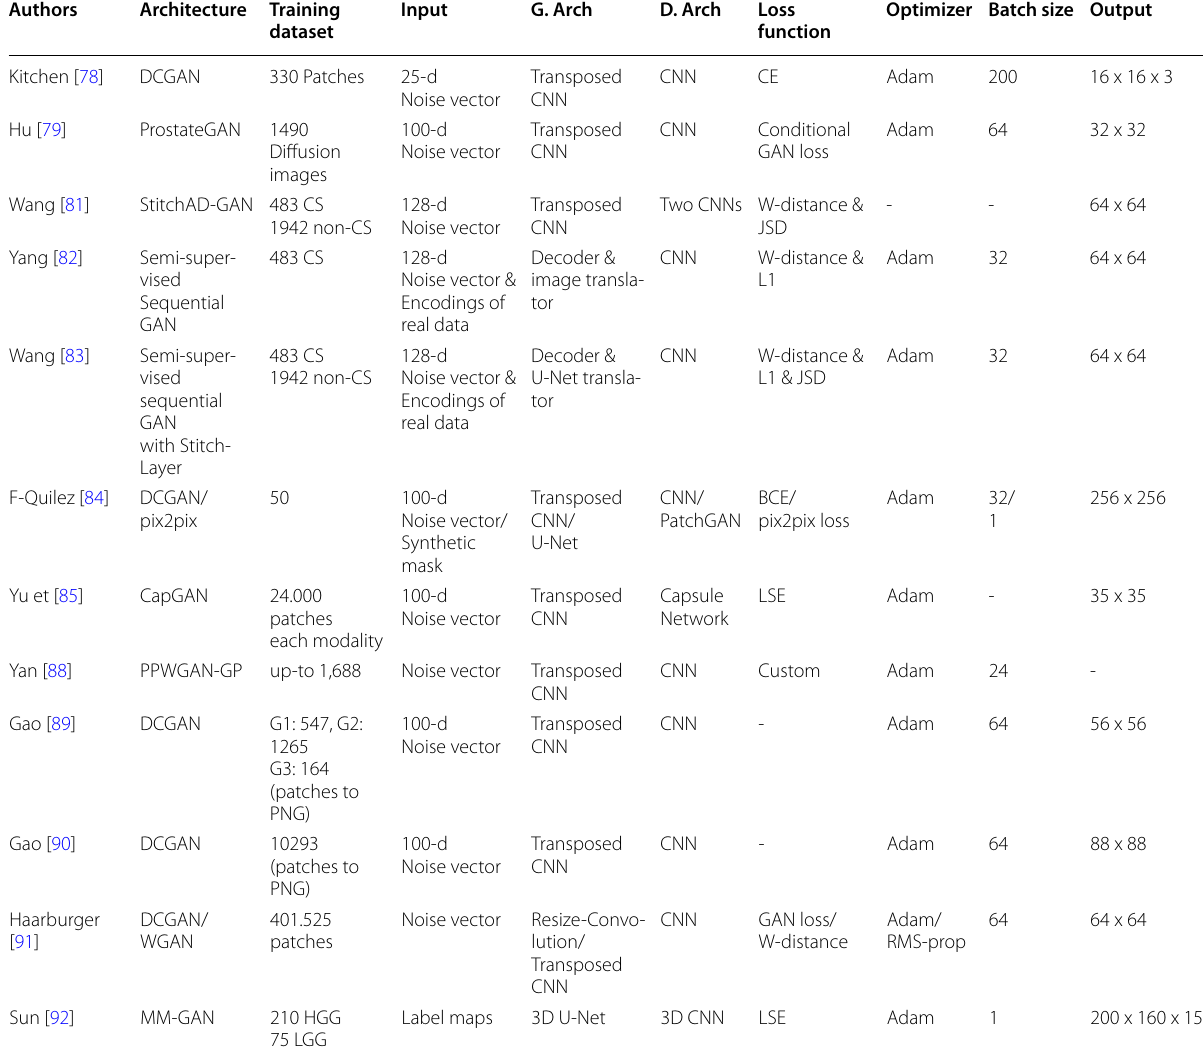
DCGAN; Deep Convolutional GAN; CNN; Convolutional Neural Network; CE, Cross-Entropy; Adam, Adaptive Moment Estimation; CS, Clinically Significant; W-distance, Wasserstein-distance; JSD, Jensen-Shannon Divergence; CapGAN, Capsule GAN; LSE, Least Square Error; PPWGAN-GP, Privacy Preserving-adversarial network; RMS- prop, Root-Mean-Squared propagation; Symbol ’-’ represents that the corresponding information was not provided in the publication